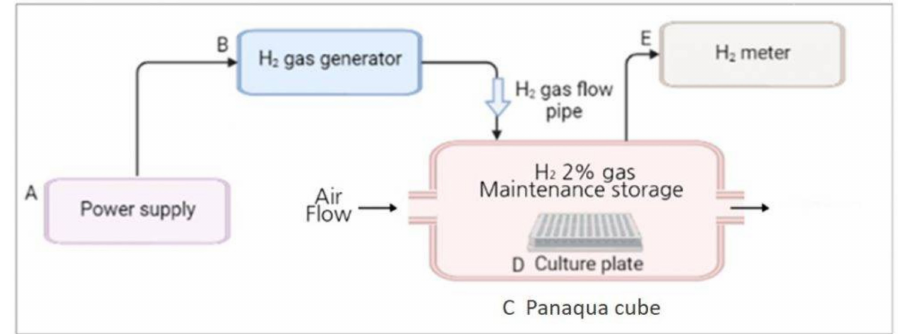
Figure 1. Overall schematic representation of the H 2 gas treatment process. ( A ) Power supply was set at around 9 volt; ( B ) H 2 gas generator (produces 2% H 2 gas); ( C ) Panaqua cube (contains culture plate for supplying H 2 gas); ( D ) Cell culture plate; ( E ) H 2 gas meter (measures the concentration of H 2 gas in the